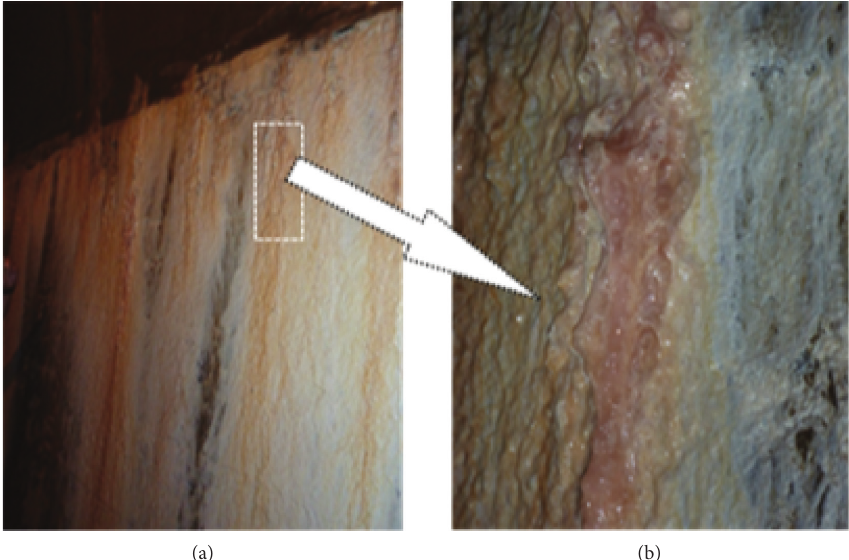
Figure 2: Advection-diffusion-driven leaching in corridors of the Shimantan concrete gravity dam overflow sections. (a) Leached calcium deposited on the surface of corridors. (b) More extensive version of leached calcium, and the main content is calcium carbonate.